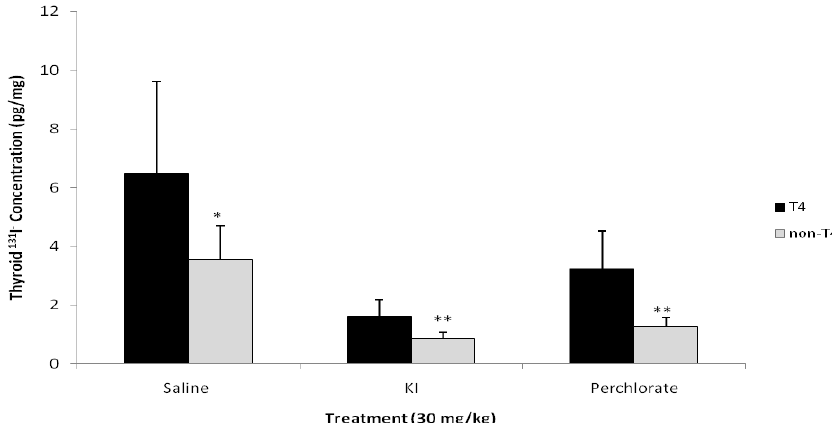
4 and n = 6 4 has a 4 ( p < 4